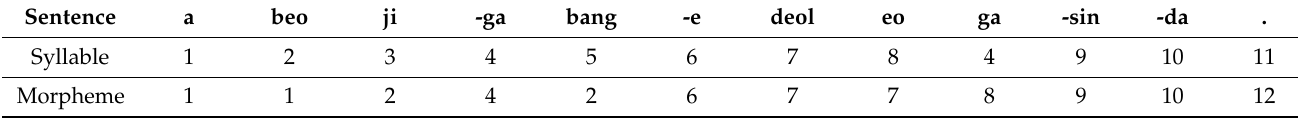
Table 4. Example of converting sentences to encoding